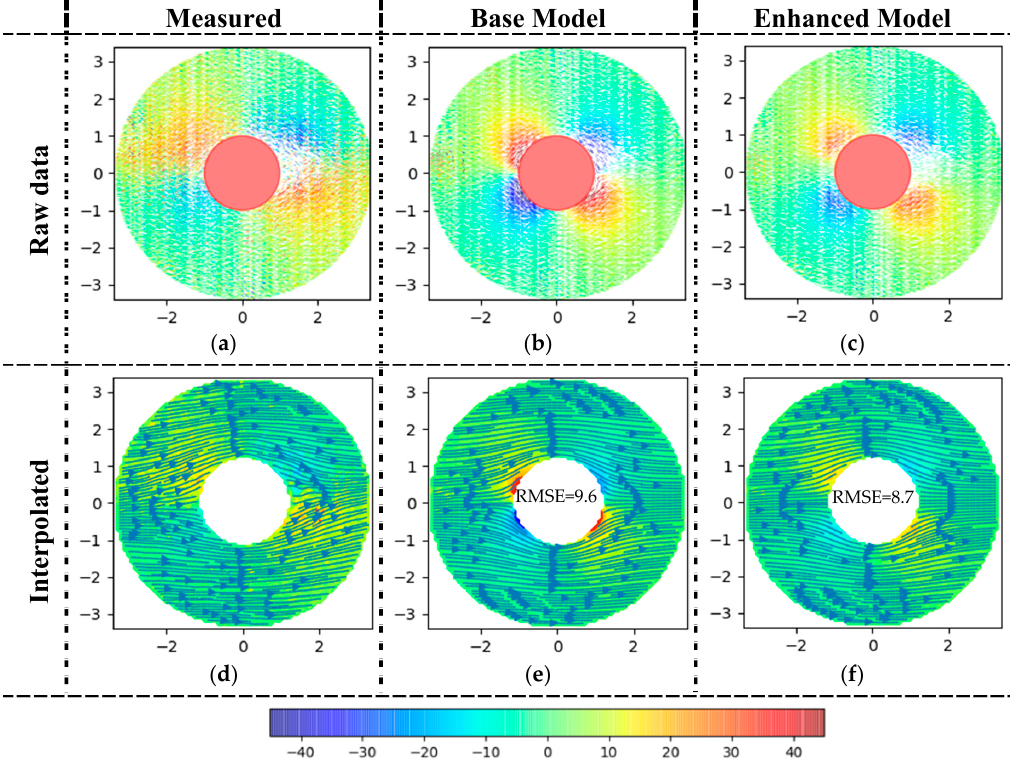
Figure 11. Comparison of the measured angles, the base model angles, and the enhanced model angles ( ◦ ). Raw data ( a ) measured, ( b ) computed with base model, ( c ) computed with enhanced model; Data interpolated on regular grid ( d ) measured, ( e ) computed with base model, ( f ) computed with enhanced model.